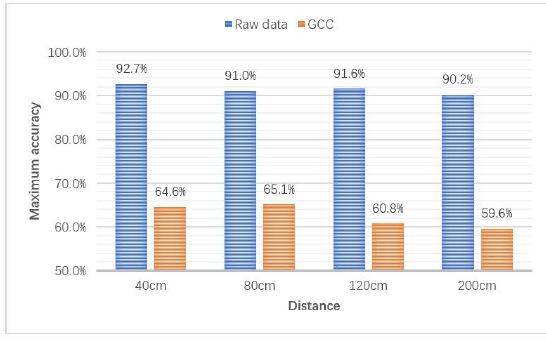
Figure 8: Based on the comparison of different feature recognition